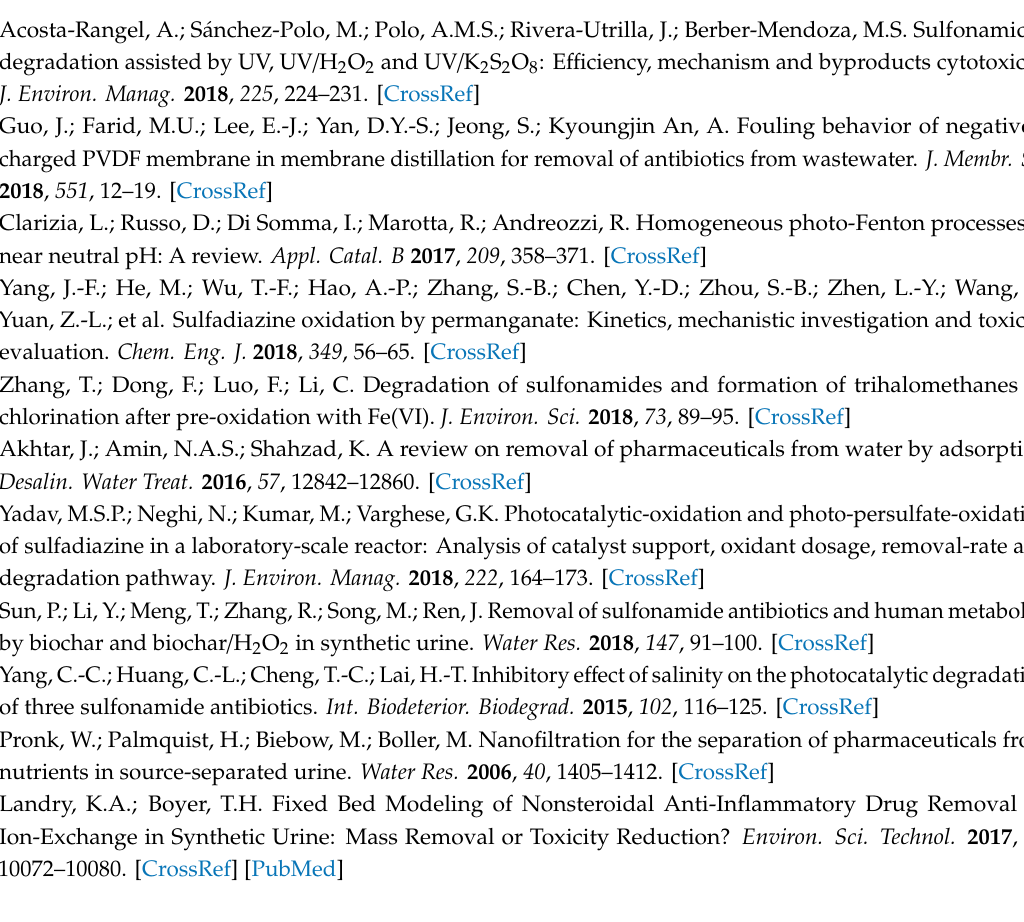
Figure S1: Schematics of the batch experiment of Photo-Fenton degradation. Figure S2: Schematic of the filtration unit with the Photo-Fenton ceramic membrane. Figure S3: The pure water fluxes of the pristine and the catalyst-coated ceramic membranes. Figure S4: (a) The degradation kinetics of SMX and (b) The apparent quantum yield (QY) under di ff erent UV 254 irradiation intensities. Initial SMX concentration: 20 mg · L − 1 ; H 2 O 2 concentration was 10 mmol · L − 1 ; and the catalyst on the ceramic membrane was 2 µ g · g − 1